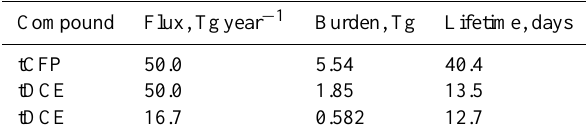
Table 1. Annual averaged, global total burdens and atmospheric lifetimes against atmospheric chemical reaction derived for